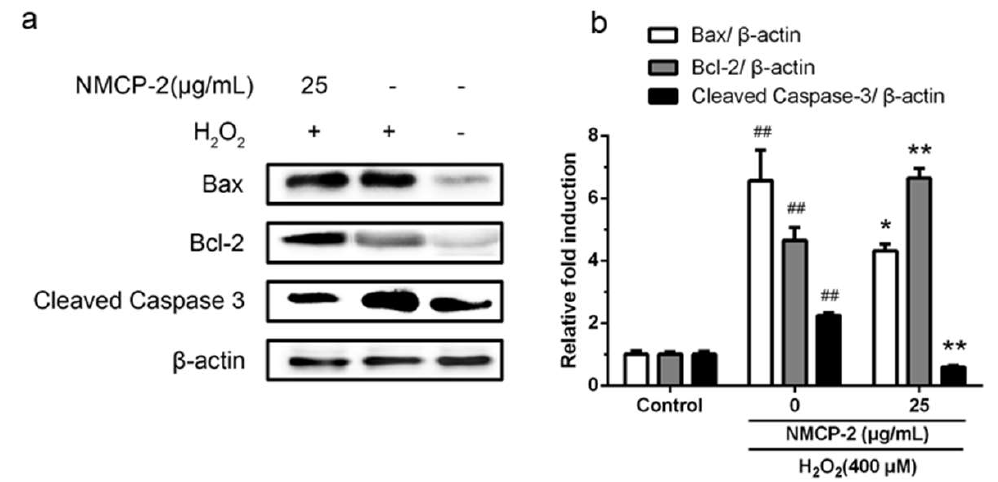
Figure 11. ( a ) Effect of NMCP-2 on Bax, Bcl-2, and caspase-3 activities of HEK 293T cells. ( b ) Bax, Bcl-2, and caspase-3 expression were quantified by densitometry and normalized to β-actin levels. Results are presented as mean ± SD of three separate experiments. ## p < 0.01 differs from control group; * p < 0.05 differs from model group; ** p < 0.01 differs from model group.